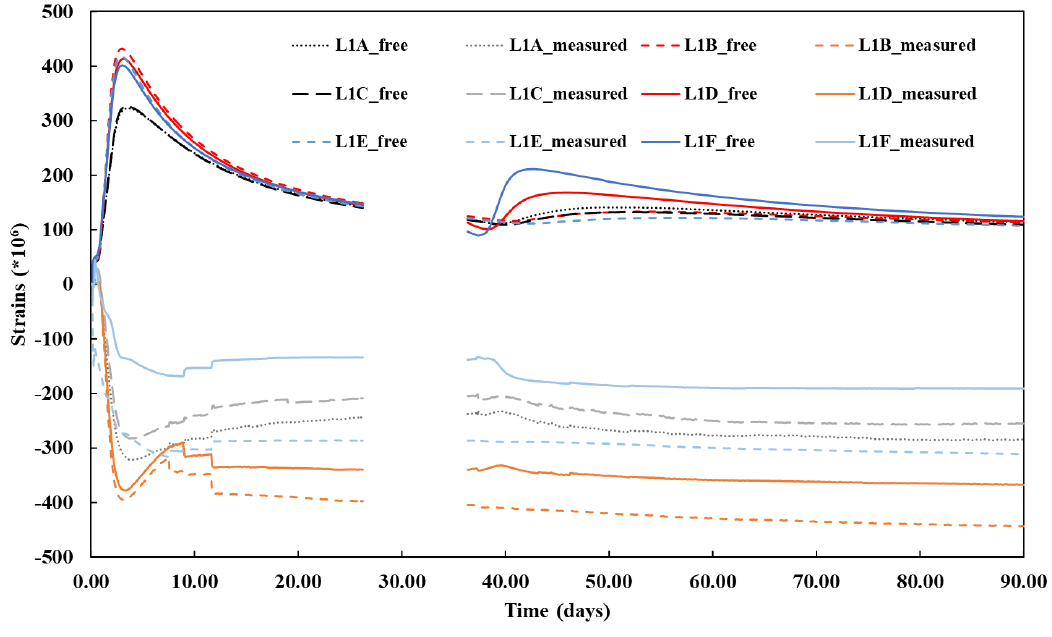
Figure 6: Free thermal strains and measured strains in time for